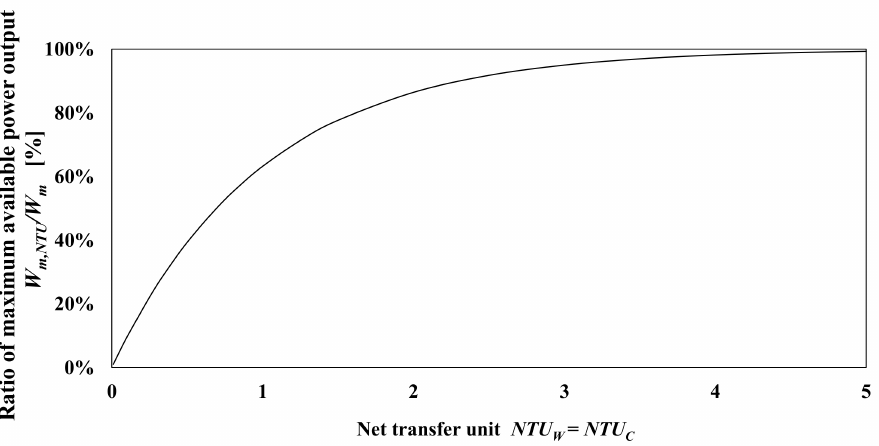
Figure 3. Dependency of the ratio of maximum available power output and net transfer unit in the case in which NTU W and NTU C are